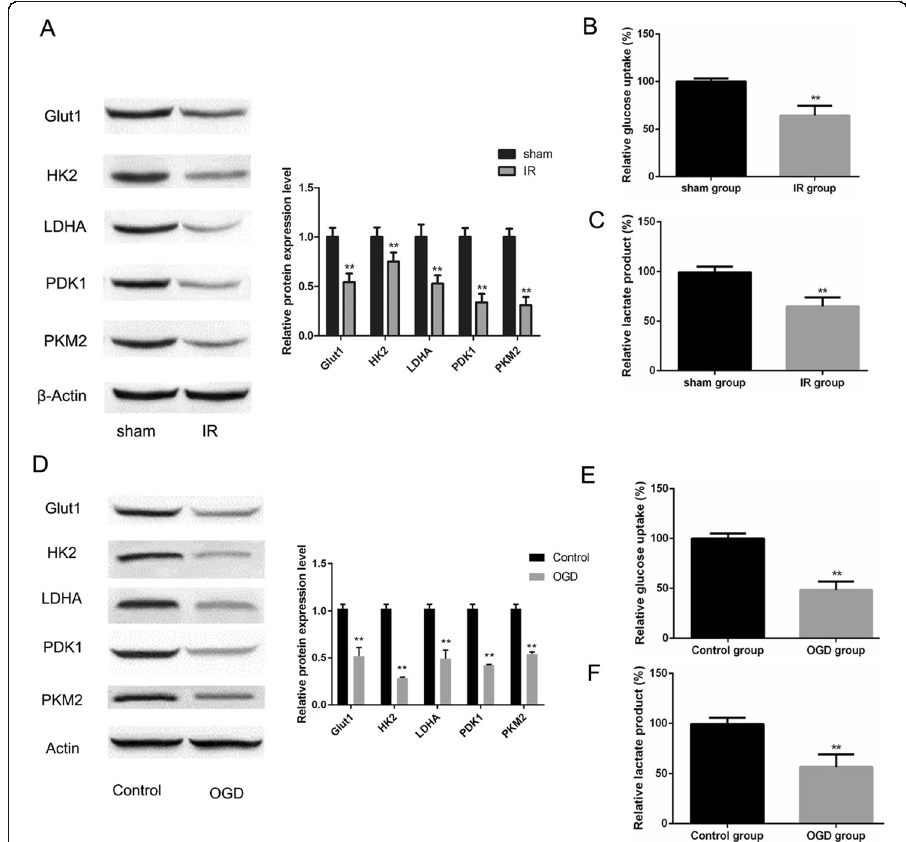
Fig. 2 Impaired glucose metabolism after IR/OGD. a , d The expression levels of glycolytic enzymes, LDHA, PKM2, HK2, Glut1 and PDK1 in IR and sham groups ( a ) and control and OGD groups ( d ) were analyzed by western blot. Representative images and densitometric analysis of blots are shown. b , d Change in glucose uptake in IR and sham groups ( b ), and control and OGD groups ( e ). c , f Difference of lactate production in IR/ sham ( c ) and OGD/control groups ( f ). For a - c , results represent 5 animals per group. For d - f , results represent 3 biological replicates. Data in b , c , e , and f were expressed as means ± SD. (** P <0.01 vs. control